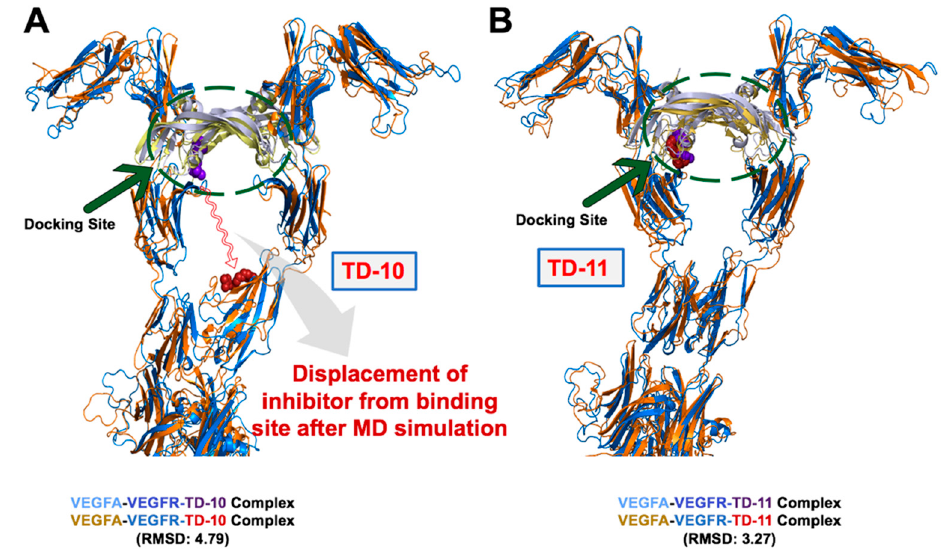
Figure 3. Superimposed structure of ( A ) VEGFA-VEGFR-1-TD-10 docked complex (grey-blue-purple) with VEGFA-VEGFR-1-TD-10 simulated structure (yellow-orange-red) Complex. ( B) VEGFA-VEGFR-1-TD-11 docked complex (grey-blue-purple) with VEGFA-VEGFR-1-TD-11 simulated complex (yellow-orange-red).